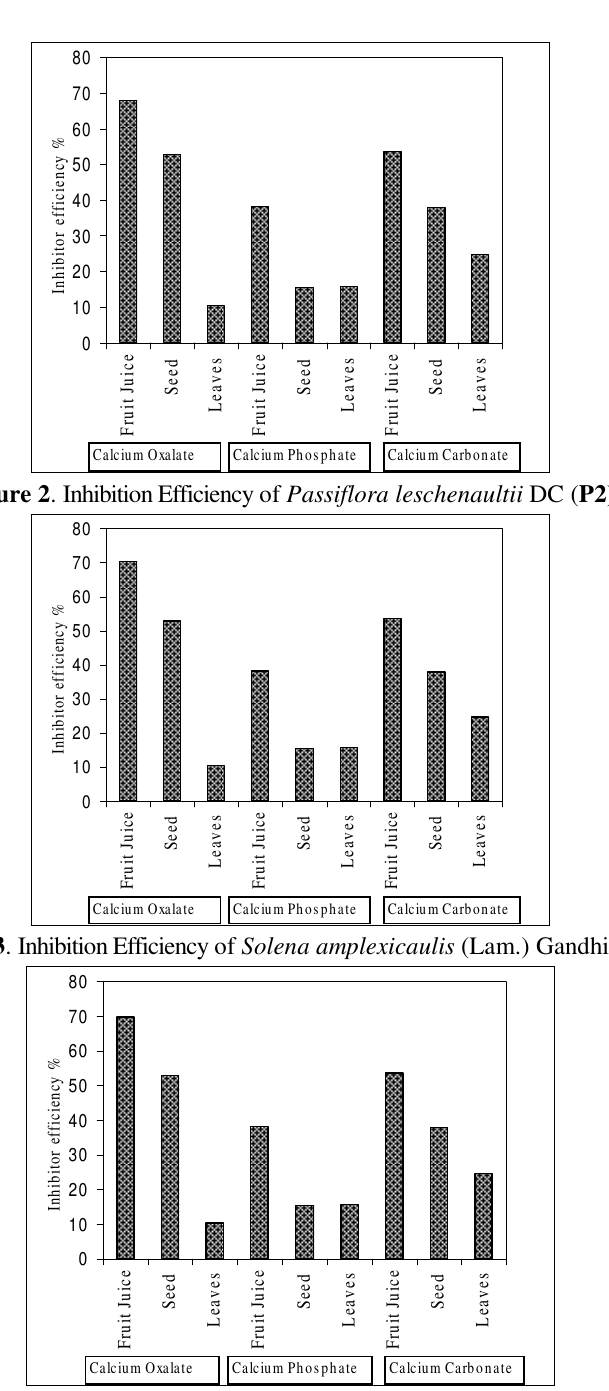
Figure 4 . Inhibition Efficiency of Scoparia dulcis Linn ( P4